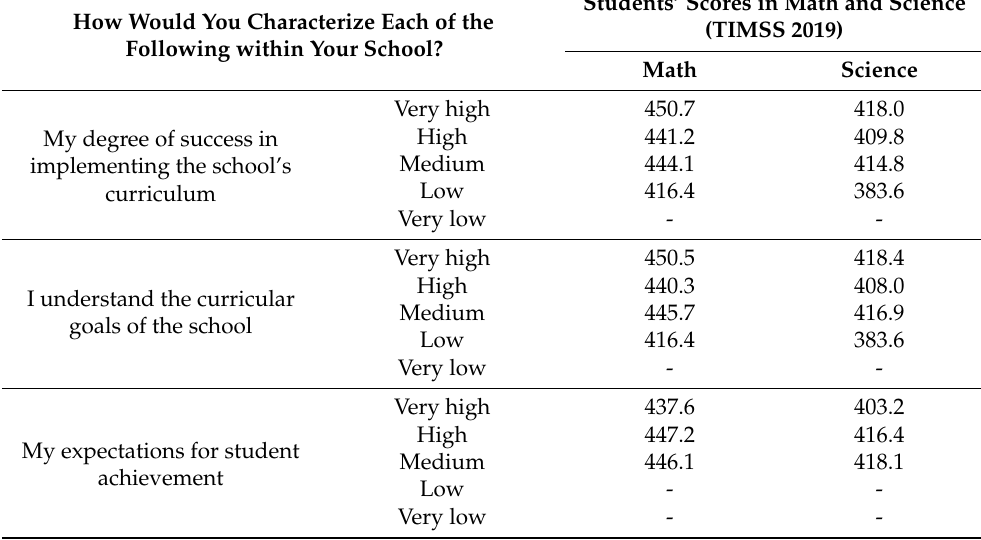
Table 3. TIMSS 2019 scores according to teacher